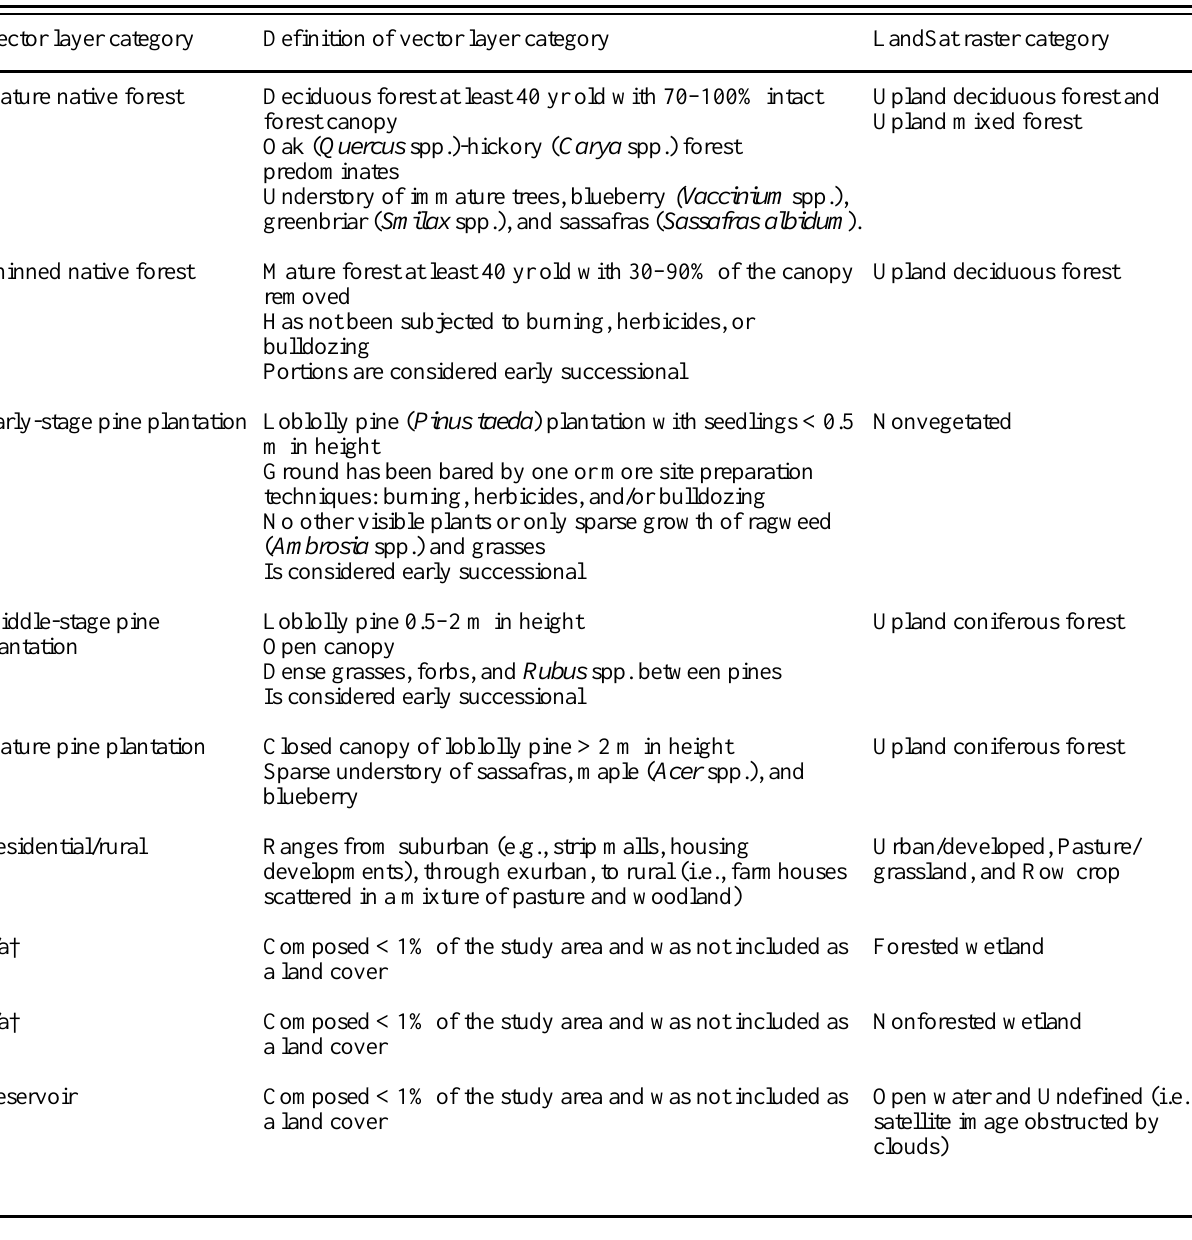
Table 2. Definitions of land cover categories in the fine-resolution vector data set, and correspondence between the land cover categories in the fine- and coarse-resolution data